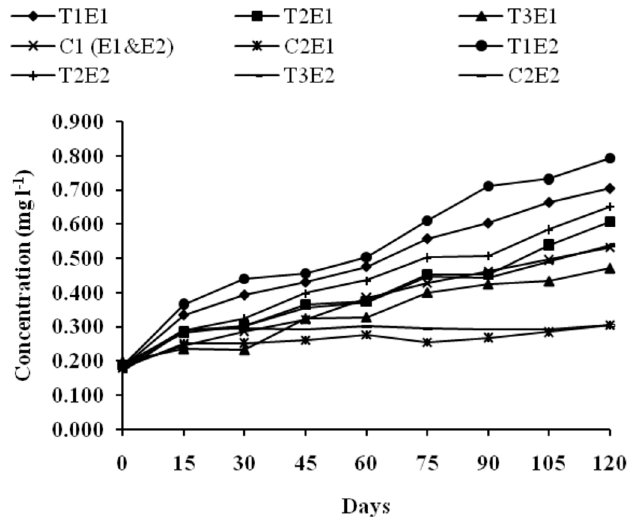
Fig. 5. Temporal changes in TAN of water inall the treatment groups in E1 and E2.